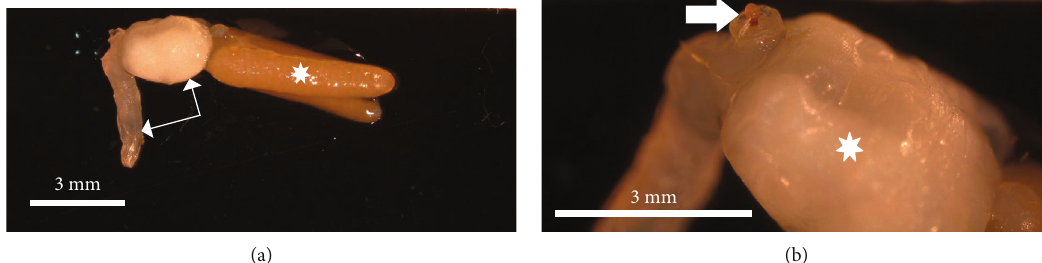
Figure 2: Overall anatomy of female presumptive Clavella sp. sampled from Gadus morhua . (a) Anatomical demonstration of cephalothorax (horizontal white arrow) and trunk (vertical white arrow). Egg strings (asterisk). (b) The bulla complex (white arrow) and trunk